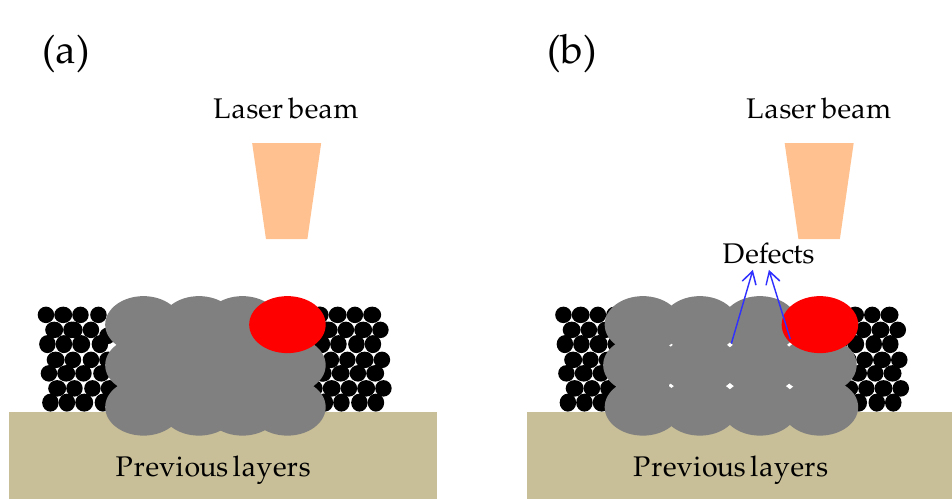
Figure 10. Schematic sketch of SLM process showing the formation of defects; ( a ) small hatch spacing; ( b ) large hatch spacing.